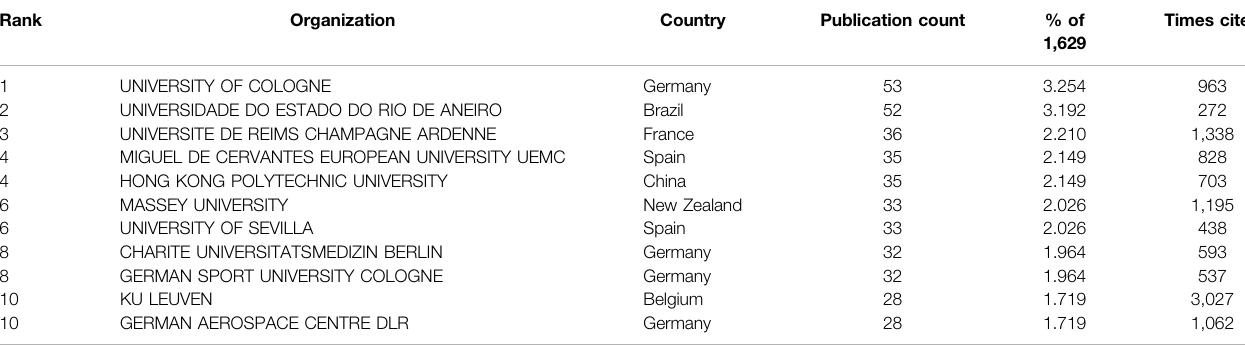
TABLE 3 | Top 10 organizations that published the most publications on WBVT.